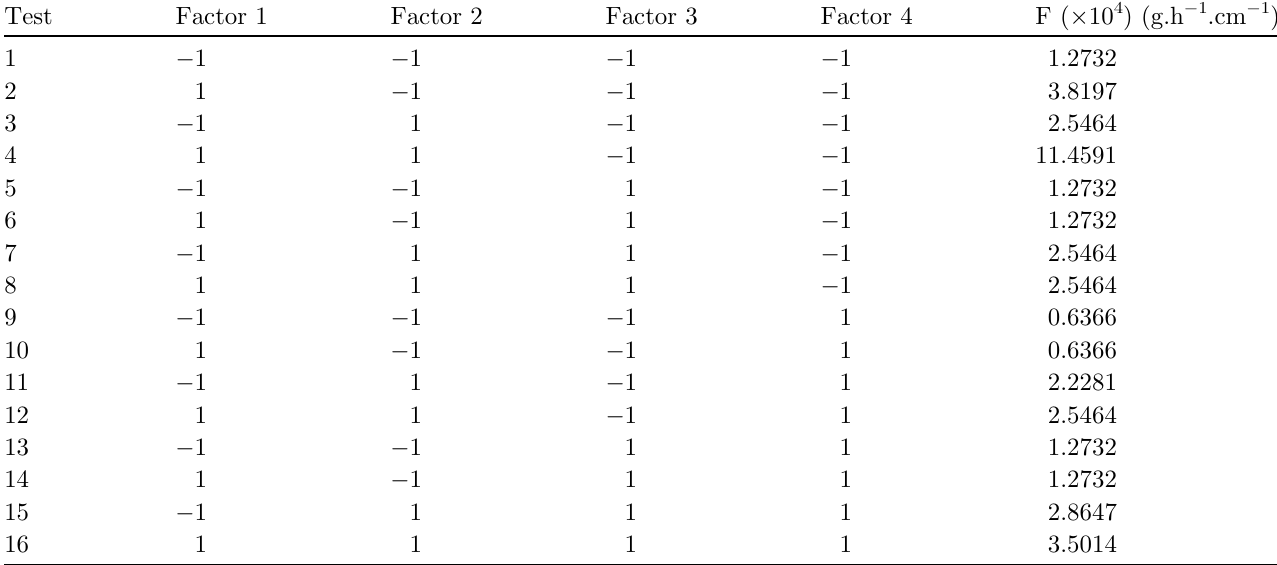
Table 3. Matrix of experiments and evaporations rate ( fl ux) F obtained for each test. Test Factor 1 Factor